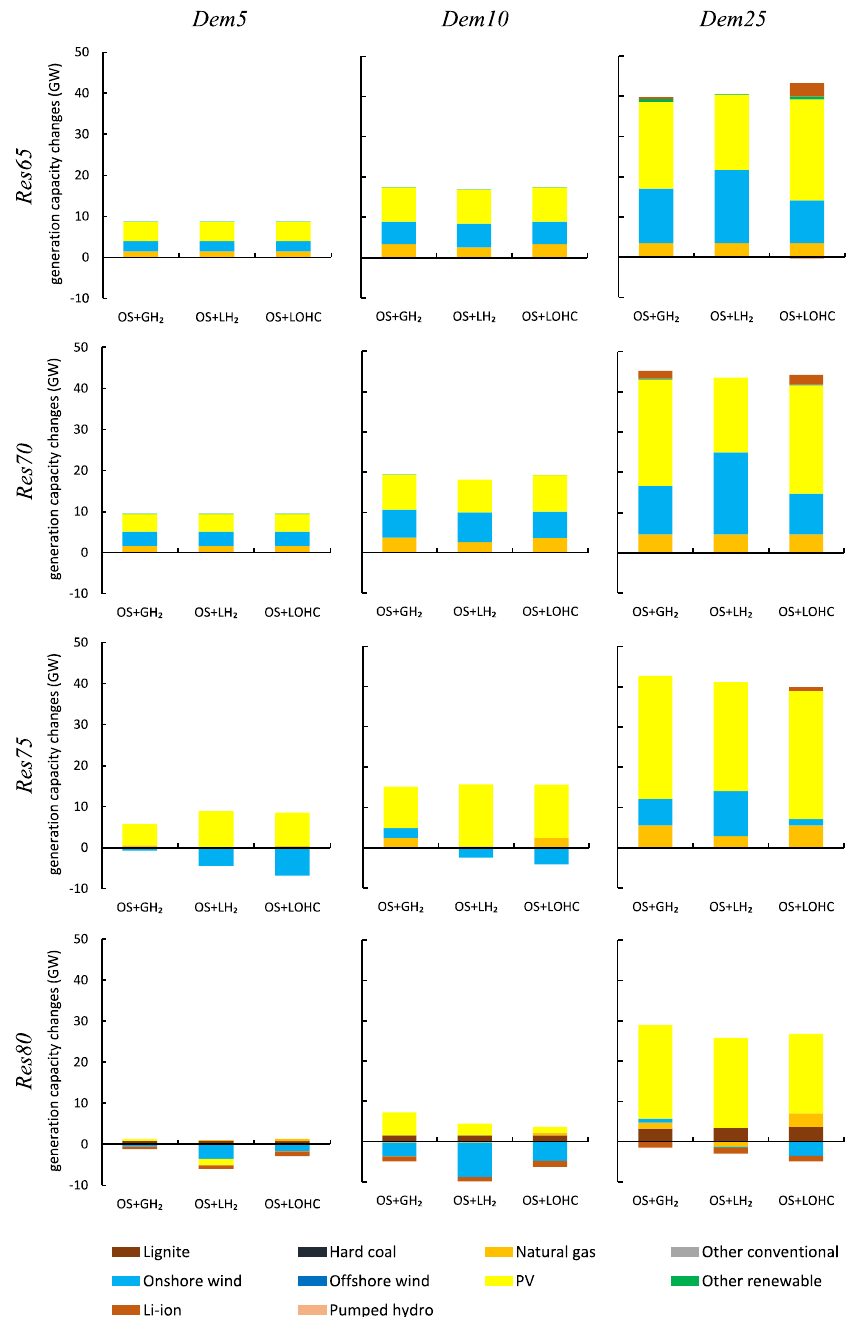
Figure 5. Electricity generation capacity changes compared to the respective baselines without hydrogen for optimal combinations of small-scale and large-scale hydrogen supply chains as shown in Fig.